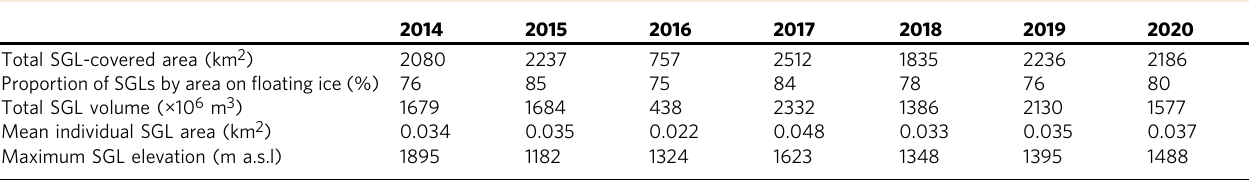
Table 2 Summary of annual January SGL